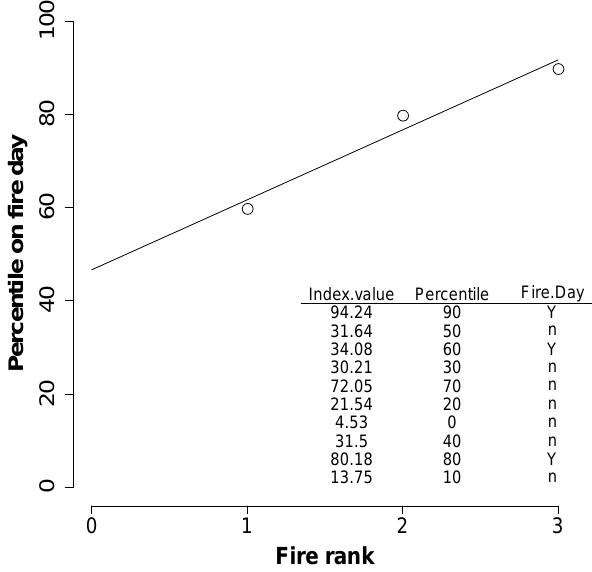
Fig. 1. Example figure for the proposed ranked percentile method of index comparison. Fire danger index values for every day are expressed as percentiles and those percentiles on days when fire occurs are plotted according to rank. The slope and intercept of a robust regression line through these points characterises the